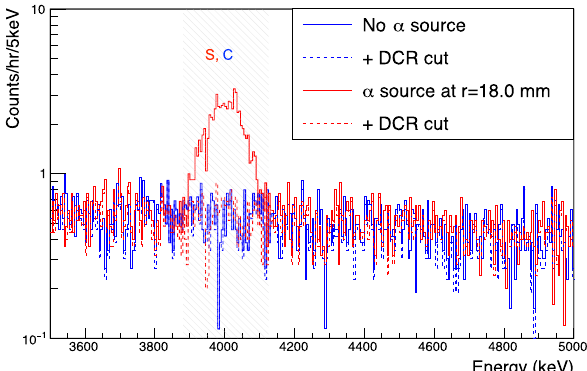
Fig. 10 The energy spectra measured with the TUBE detector without the α source incident on the passivated surface, in blue, and with the source incident at r=18.0mm, in red. Spectra are shown before (the solid lines) and after (the dashed lines) the application of the DCR cut. The hatched energy window is used for the α survival probability calculation. The regions indicated here correspond to the variables in Eq.